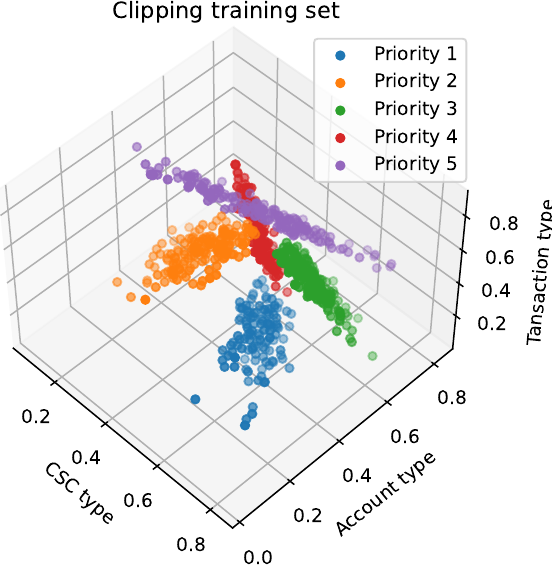
Figure 12. Clipping training set scatter